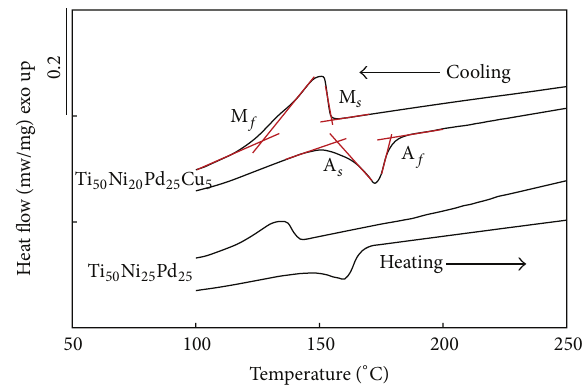
Figure 1: DSC heating and cooling curves showing the transforma- tion temperatures of Ti 50 Ni 25 Pd 25 and Ti 50 Ni 20 Pd 25 Cu 5 alloys.